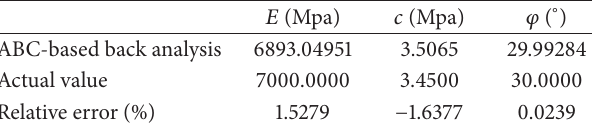
Table 2: Identified parameters using ABC-based back